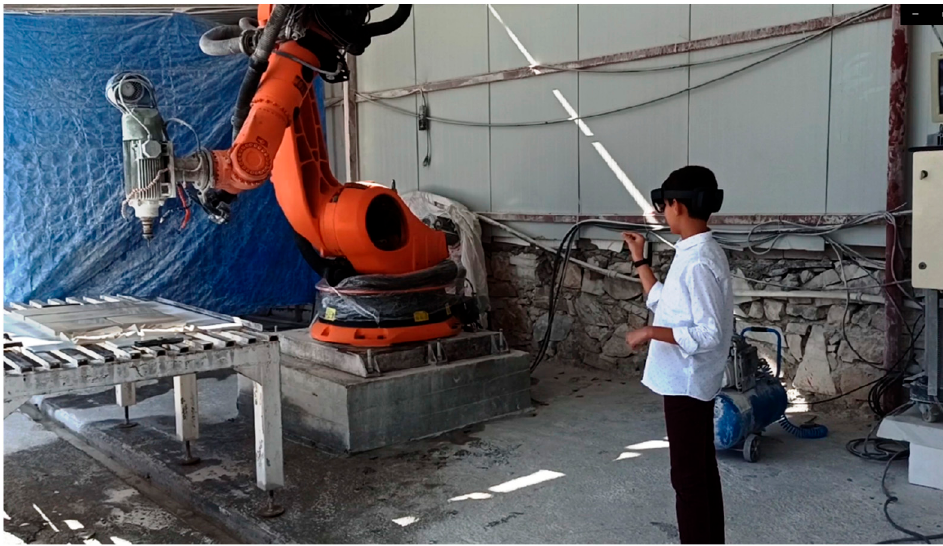
Figure 14. The user can change the parameters of parametric-design and robotic-fabrication tasks within mixed-reality environment.